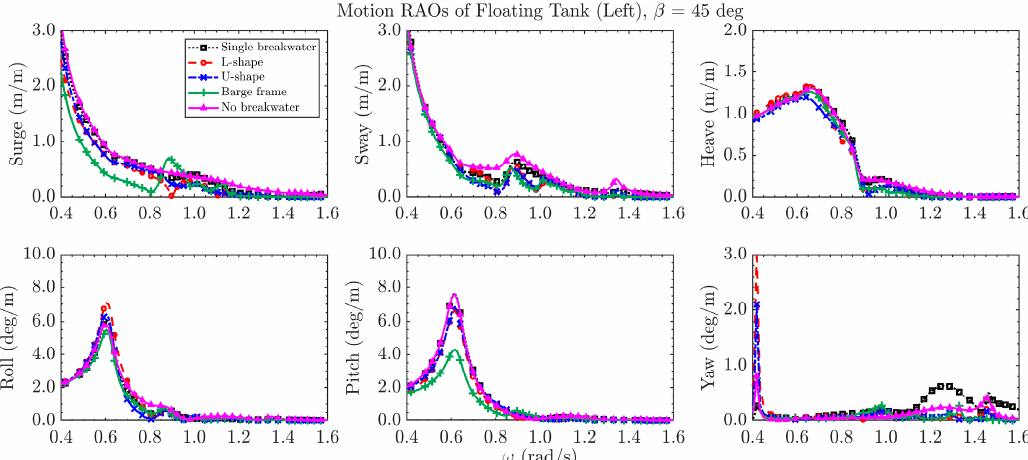
Figure 12. Motion RAOs of the left-hand-side floating tank with the different configurations of floating breakwaters in 45 deg incident wave direction.